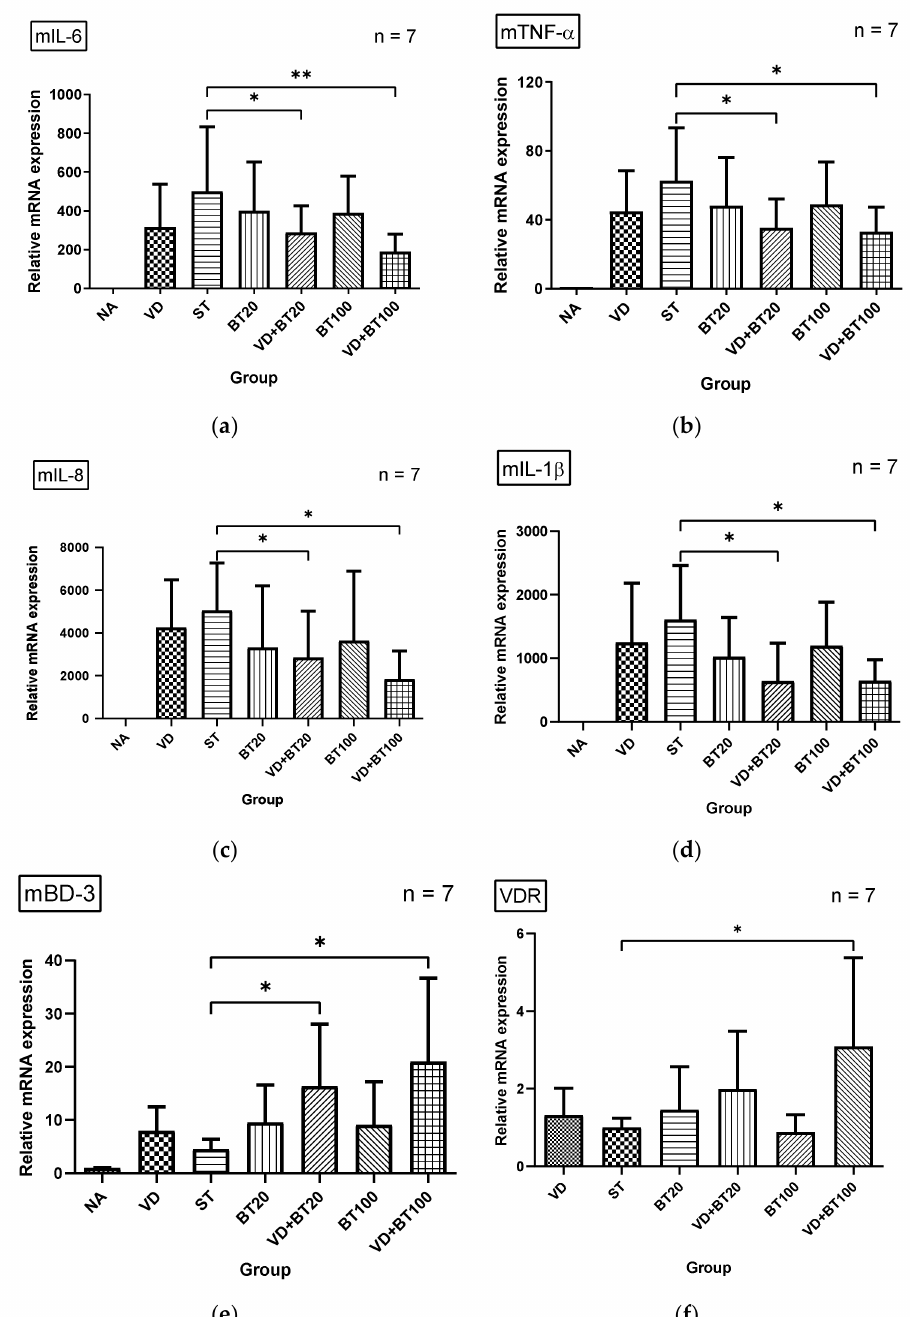
Figure 2. The immunomodulatory effects of 1,25D3 and butyrate on local cytokines and antimicrobial peptide in the cecum of Salmonella colitis mice. After Salmonella infection for 48 h, cecal tissues were obtained from the control, Salmonella -infected, and 1,25D3 and/or butyrate-treated infected mice. Total RNA was extracted from the cecal tissues. mIL-6 ( a ), mTNF- α ( b ), mIL-8 ( c ), mBD-3 ( d ), mIL-1 β ( e ), and VDR ( f ) mRNA expressions were analyzed by quantitative RT-PCR. Values are measured as fold increase compared to the level of the control mice. The data shown are means ± the SEM (n = 7 mice/group). An asterisk indicates significant differences among groups, based on one-way ANOVA. *, p < 0.05, ** p <